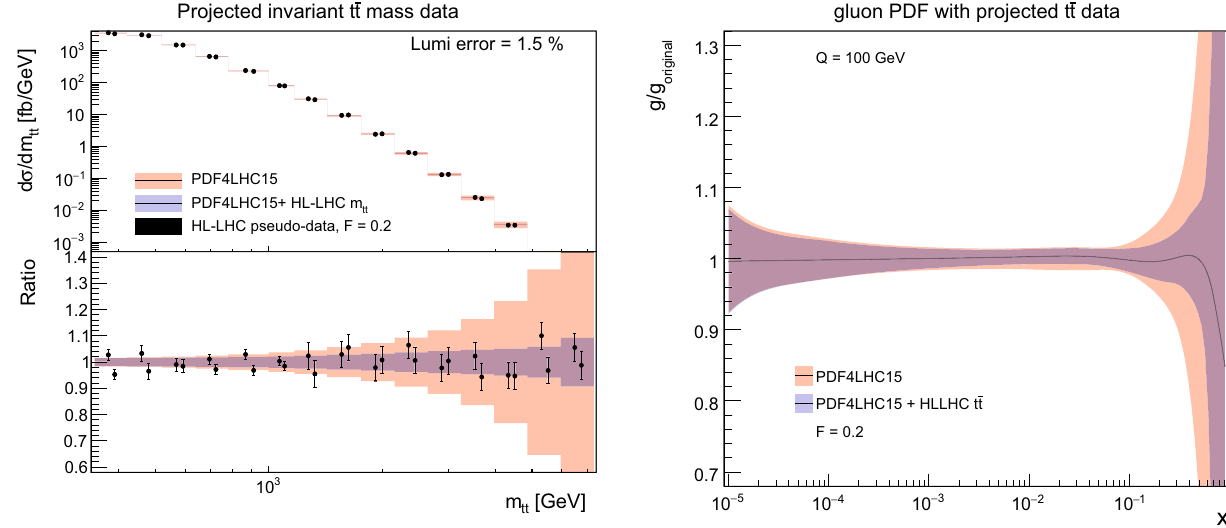
Fig. 8 Left: As in Fig. 5, now for the m t ¯ t distribution in top quark pair production. Right: As in Fig. 6, now for the gluon PDF after including the HL–LHC t ¯ t pseudo–data in the fit −1−0.8−0.6−0.4−0.200.20.40.60.81 PDF4LHC15 + HLLHC p Fig. 9 As in Fig. 4, now for the correlation coefficient between the gluon PDF and the central rapidity bin of the inclusive jet (left) and direct photon (right)